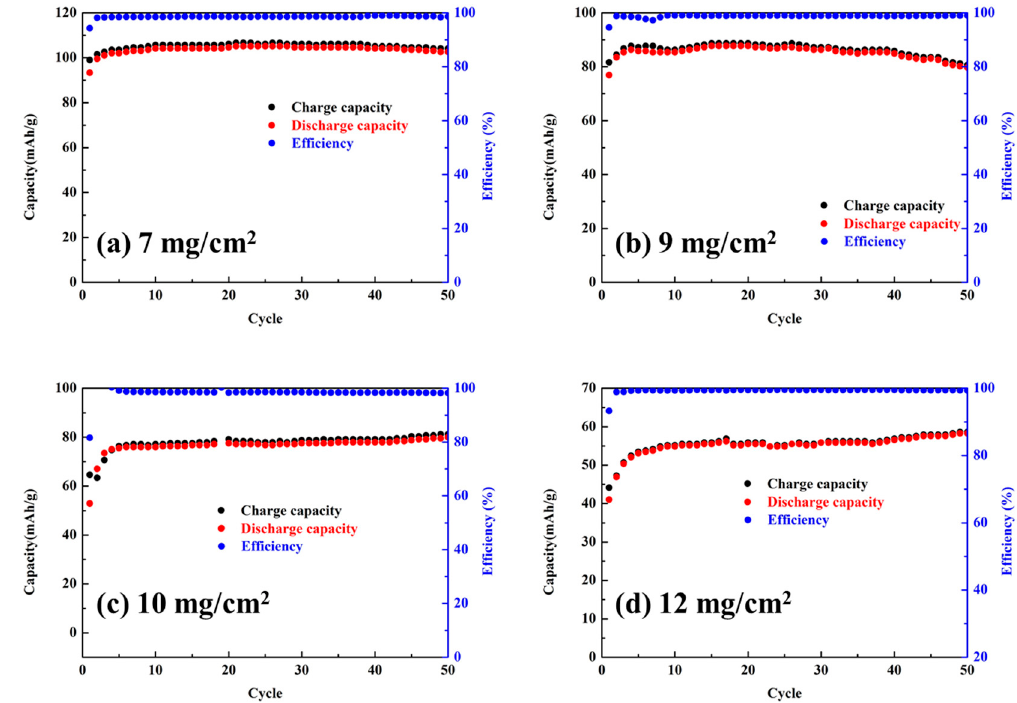
Figure 3. Cycling performance of Al batteries with loading of graphite electrode at a current density of 100 mA/g: ( a ) 7; ( b ) 9; ( c ) 10; and ( d ) 12 mg/cm 2 .